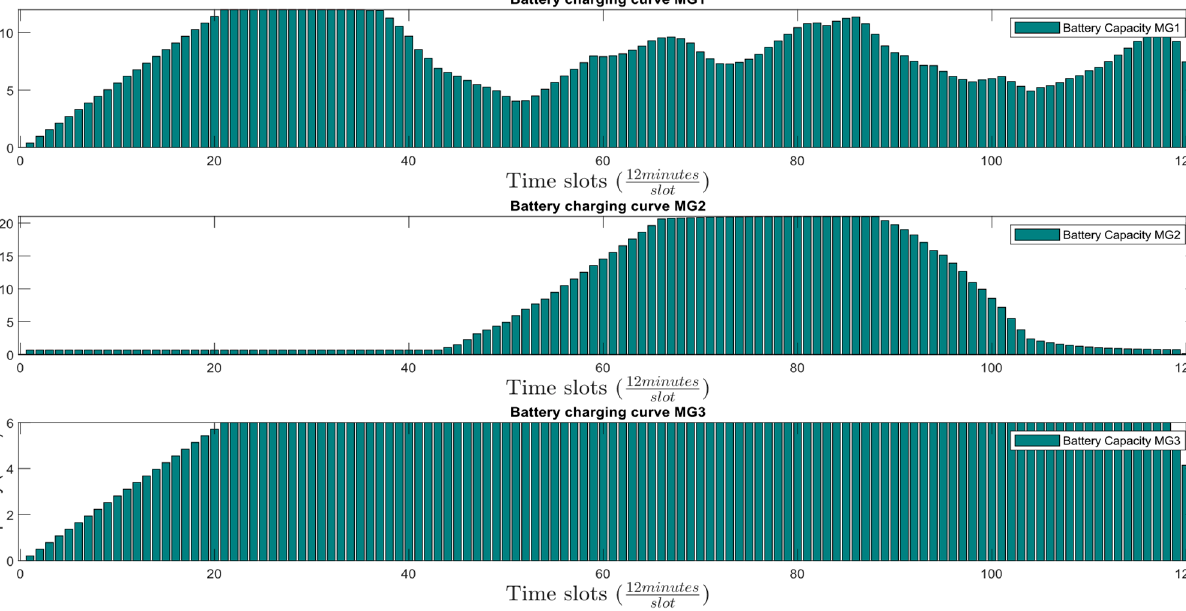
Figure 26. Power demand and surplus before LETM network for scheduled load in scenario 3.